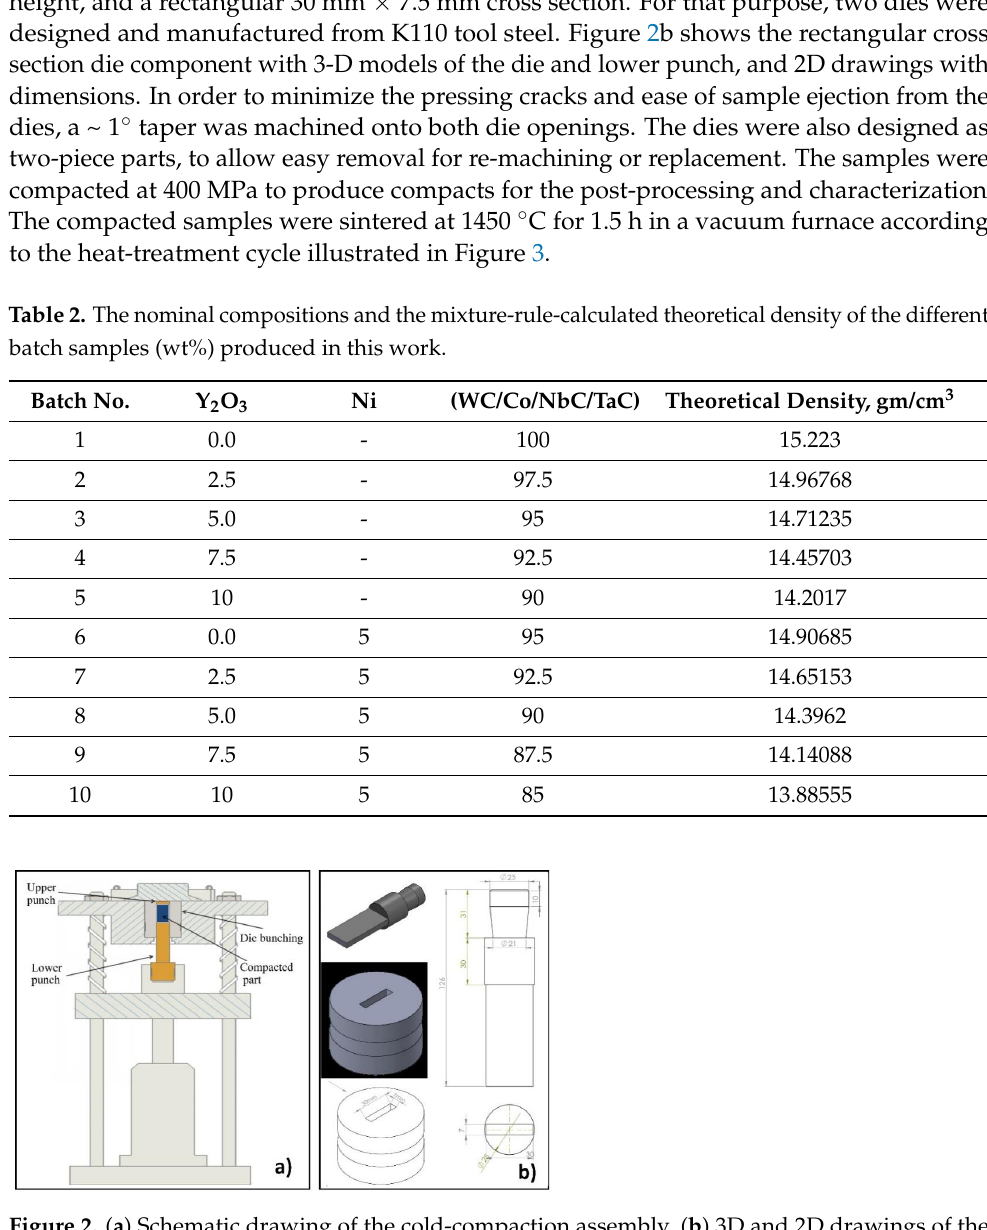
Figure 3. Heat-treatment thermal cycle applied in the compacted cemented carbide sintering pro- cess. 2.3. Characteriztion of the Consolidated Composites Densification is one of the important parameters for the consolidated powder that determines the properties of the produced bulk materials. Densification is determined through the bulk density and the apparent porosity using the Archimedes method, taking distilled water as floating media according to the ASTM D1217 standard. The consolidated samples were prepared through the standard metallographic pro- cedures, first grinding with SiC grit papers of different grades up to 3000, and then me- chanically polishing using 6 µm and 3 µm diamond paste. The microstructure of the dif- ferent samples was investigated using a field emission gun scanning electron microscope (FEG-SEM, FEI company, Hillsboro, OR, USA) equipped with an EDS system (EDAX, AMETEK, Utah, Draper, South Pearl, CO, USA). X-ray diffraction (XRD) was used to iden- tify the different phases that formed upon the consolidation process. We used an auto- mated Siemens Model D-5000 diffractometer (Malvern Panalytical, Westborough, MA, USA) with Cu K-alpha radiation operated at 40 kV and 30 mA in the 2θ range of 20–100° at the step of 0.05°. The obtained XRD charts from the consolidated samples were com- pared with that of the mixed powder before consolidation. Hardness measurements, fracture toughness, TRS and compressive-strength evalua- tions were used as the bases for assessing the mechanical properties of the composites. Vickers hardness operated at a load of 30 kg was used for the hardness test measurement. The fracture toughness was evaluated from the measurement of the total crack lengths 200